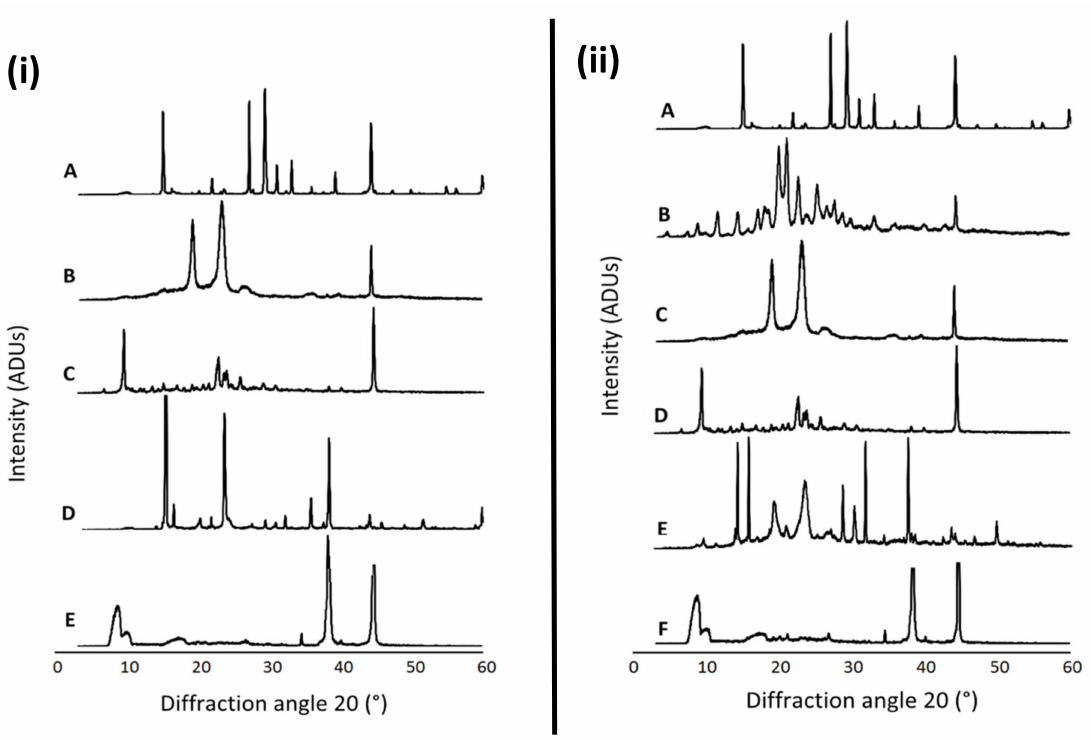
Figure 1. ( i ) P68 + DQA NAC. XRD patterns of ( A ) NAC, ( B ) P68, ( C ) DQA, ( D ) a physical mixture of P68, DQA and NAC in the same ratio as the nanoformulation and ( E ) lyophilized P68 + DQA NAC nanoformulation. ( ii ) P68 + DQA NAC + DFO. XRD patterns of ( A ) NAC, ( B ) DFO, ( C ) P68, ( D ) DQA, ( E ) a physical mixture of P68, DQA, NAC and DFO in the same ratio as the nanoformulation and ( F ) lyophilized P68 + DQA NAC + DFO